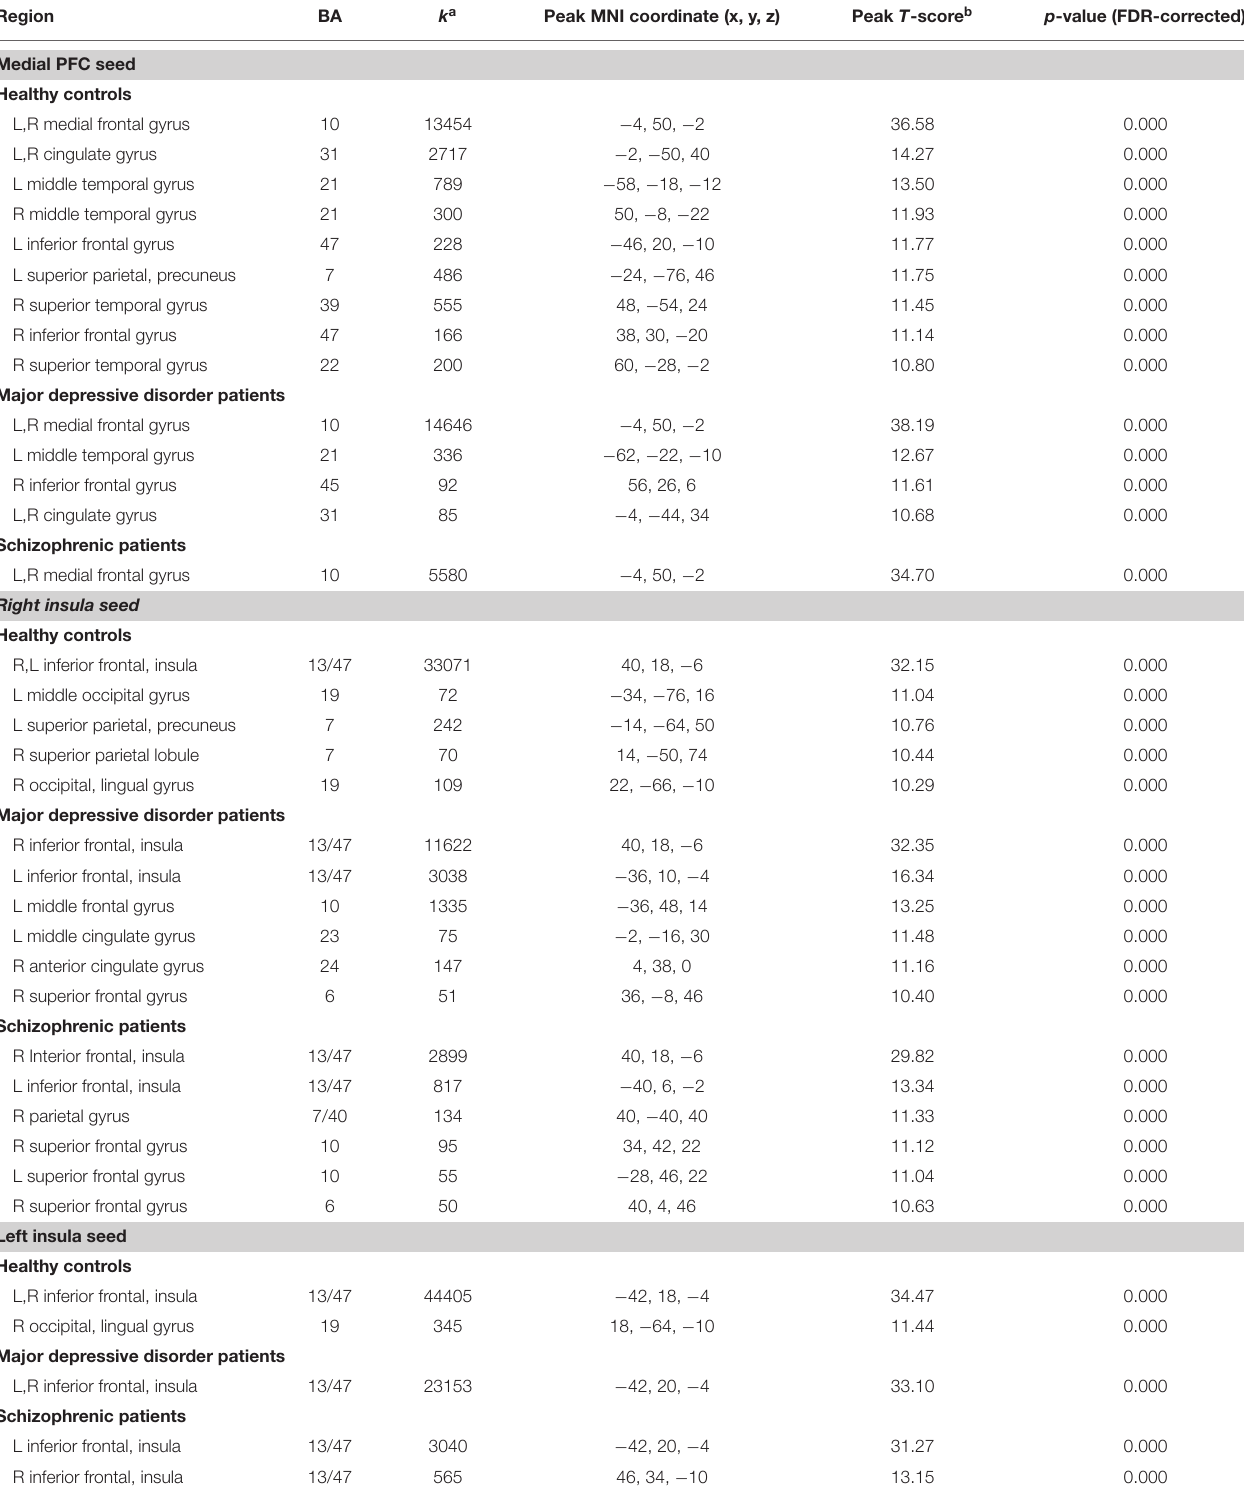
TABLE 2 | Clusters of within-group seed connectivity.